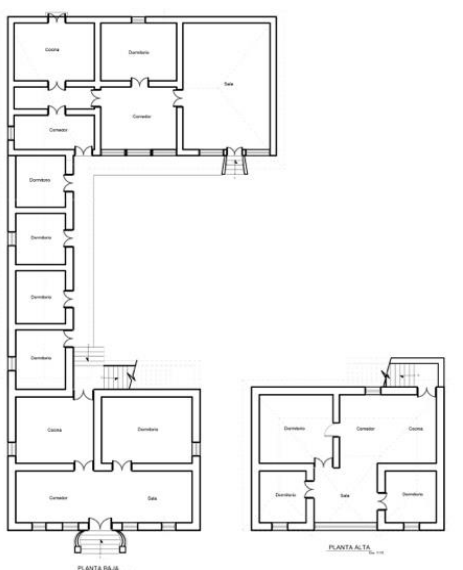
Figure 2. Internal distribution, Hacienda type house, Nono, Ecuador,